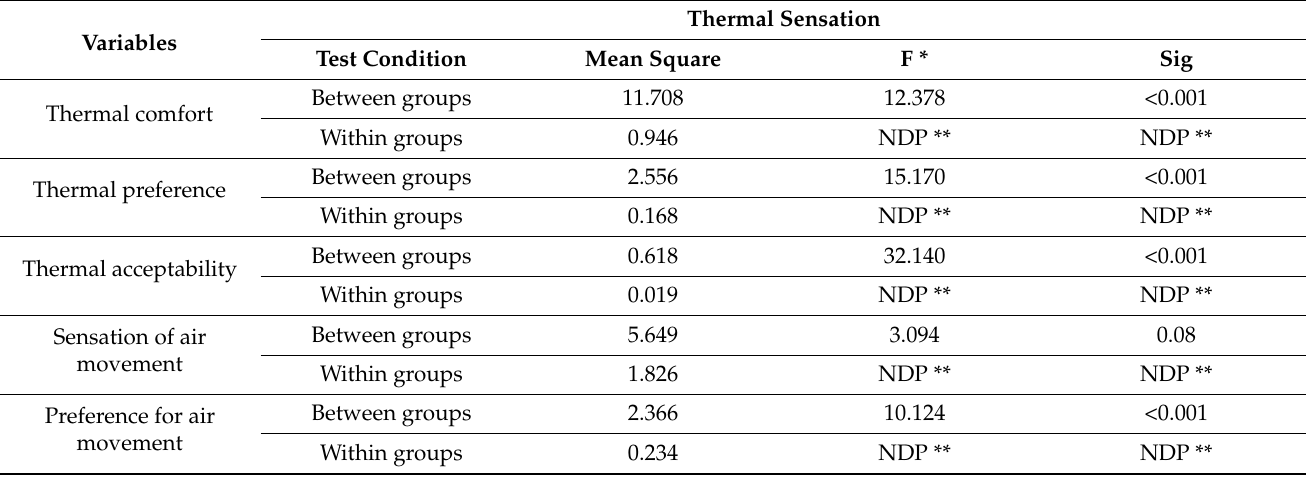
Table 4. Summary of the statistical tests between the variables assessed during the surveys (N = 110).